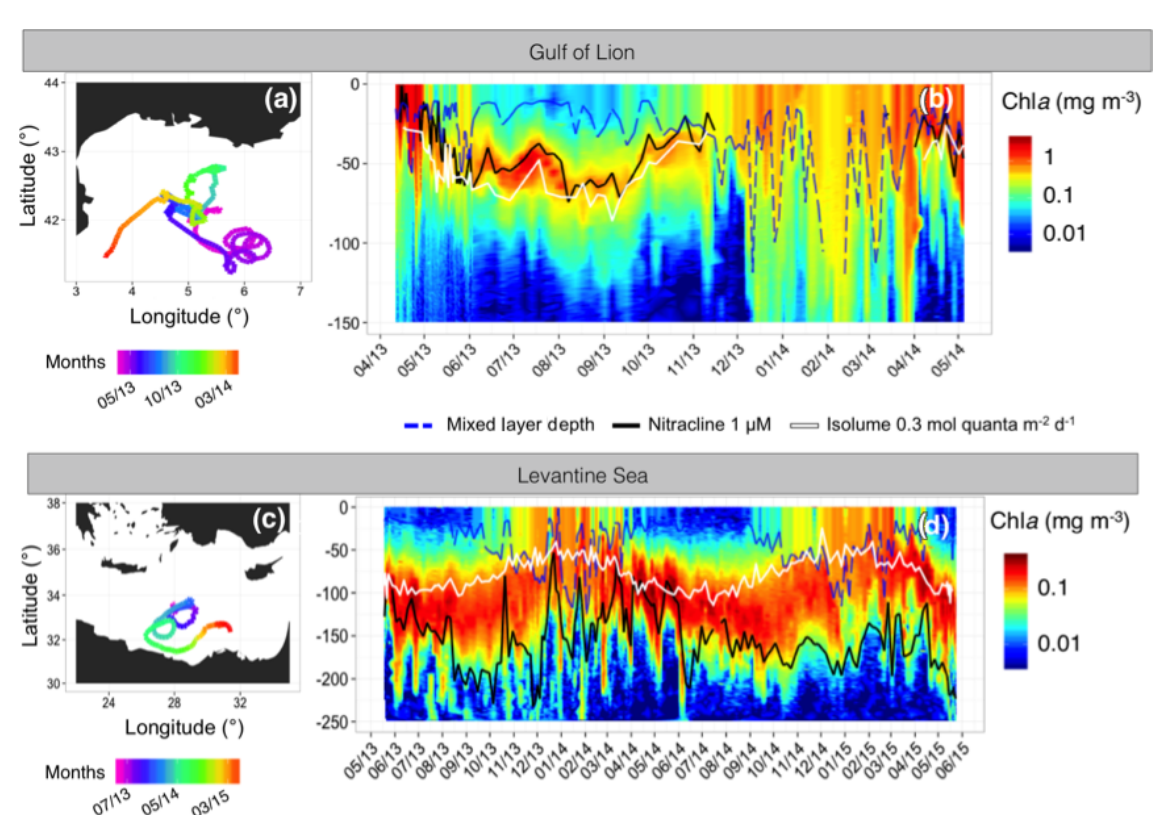
Figure 10. Trajectory and Chl a time series of the float deployed in the Gulf of Lion (fGL; a–b ) and the float deployed in the Levantine Sea (fLS; c–d ). On panels b and d, the white line shows the isolume of 0.3molquantam − 2 d − 1 , the blue line indicates the mixed layer depth (MLD) and the black line the nitracline